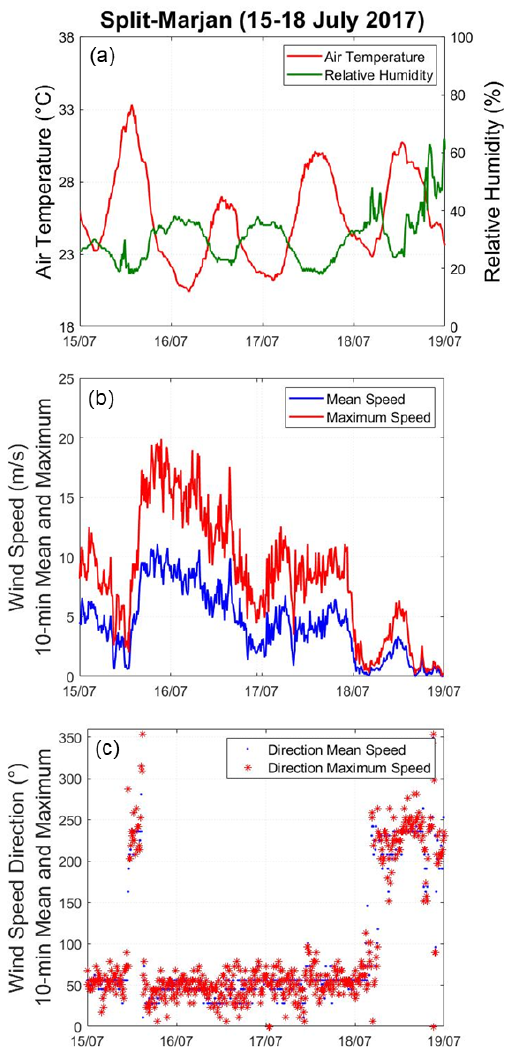
Figure 8. Split-Marjan automatic weather station 10min observa- tions of (a) air temperature ( ◦ C) and relative humidity (%), (b) mean and maximum wind speed (ms − 1 ), and (c) mean and maximum wind direction ( ◦ ) from 15 to 18 July